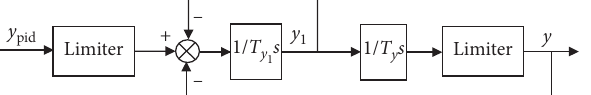
Figure 4: AC servo motor/electrohydraulic actuator type servo